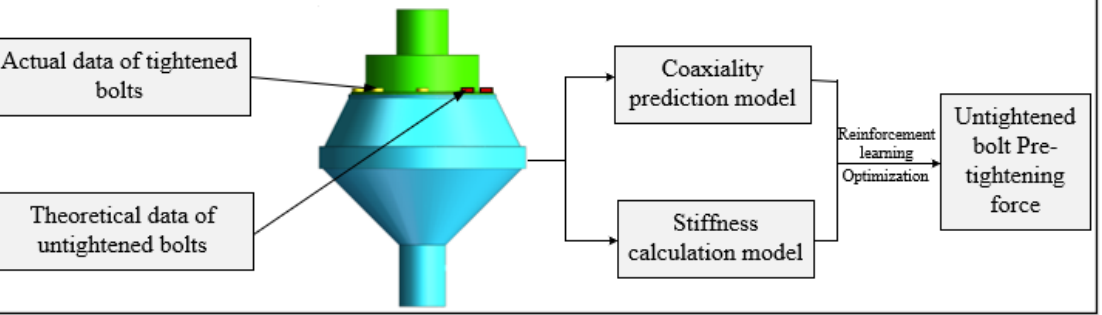
Figure 3. Semi-physical simulation framework for the tightening process